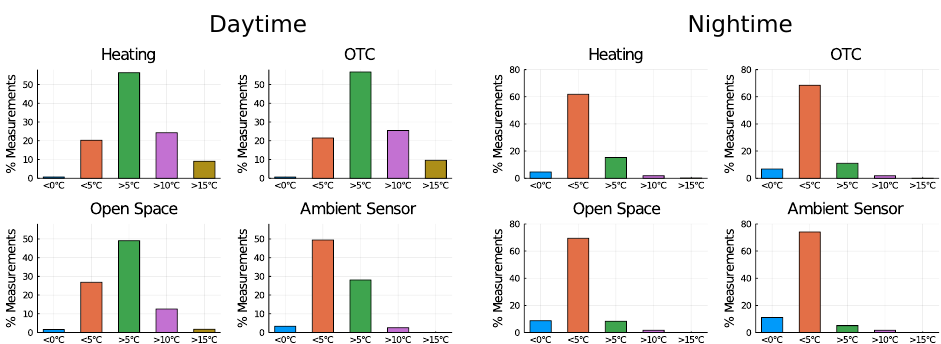
Figure 12. Customized temperature histograms segmented by groups and period (daytime or